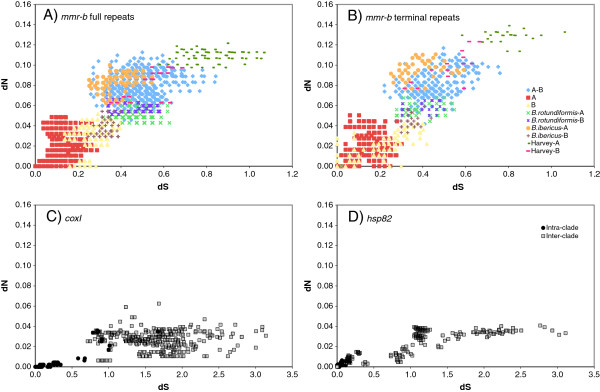
dN vs dS for coding sequences. (A) mmr-b full repeats; (B) mmr-b terminal repeats; (C) coxI; (D) hsp82. Differently colored symbols indicate different intra- and inter-clade or clade-phylotype pairwise comparisons.